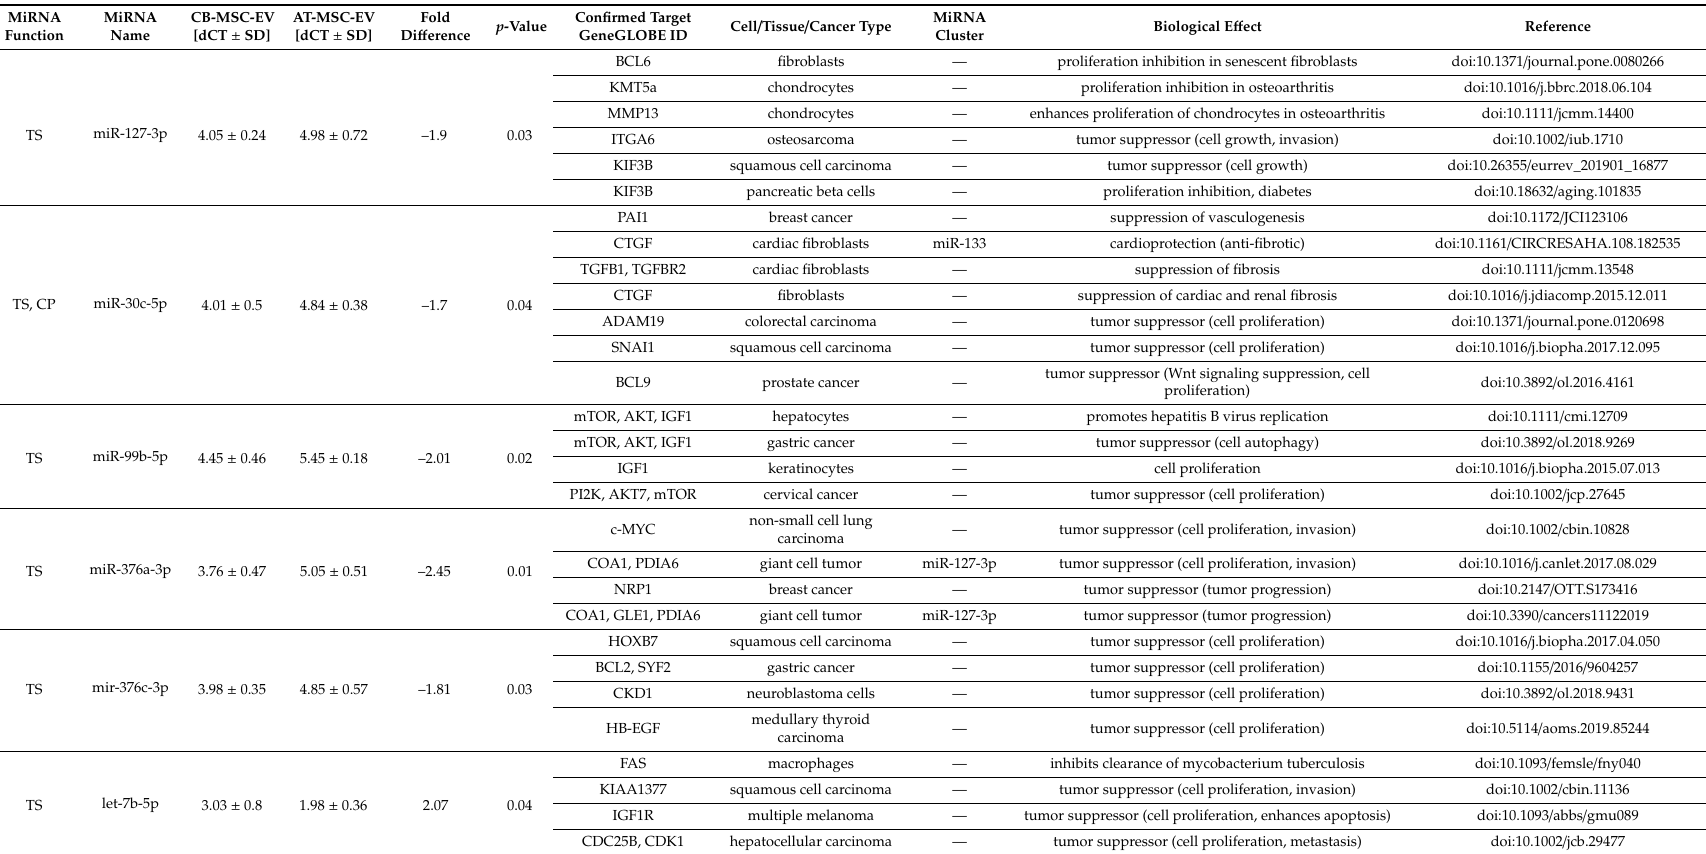
Table A1. MiRNAs that are known tumor suppressors (TS). Selected miRNAs are also involved in cardioprotection (CP). Targets are given for each miRNA, with no claim to completeness. Pubmed IDs (PMIDs) are given as references when no DOI numbers are